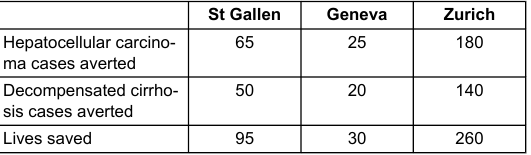
Table 4: Hepatocellular carcinoma and decompensated cirrhosis cas- es averted, and lives saved from 2015–2030 under the Swiss Hepatitis Strategy, by canton.